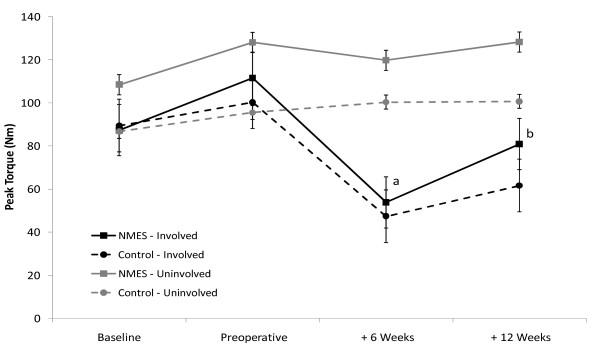
Quadriceps Femoris Muscle Strength. ap < 0.05 vs. Preoperative; bp < 0.05 vs. + 6 Weeks; Error Bars represent Standard Error